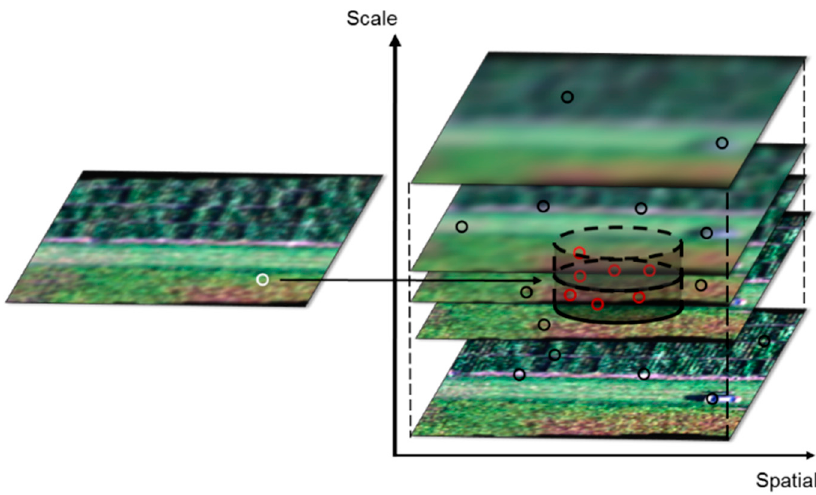
Figure 4. Search space constraints in the spatial and scale domains. The radius and the height of the cylinder represent the extent of the search space in the spatial and scale domains, respectively, for a feature in the template image (i.e., marked white circle).